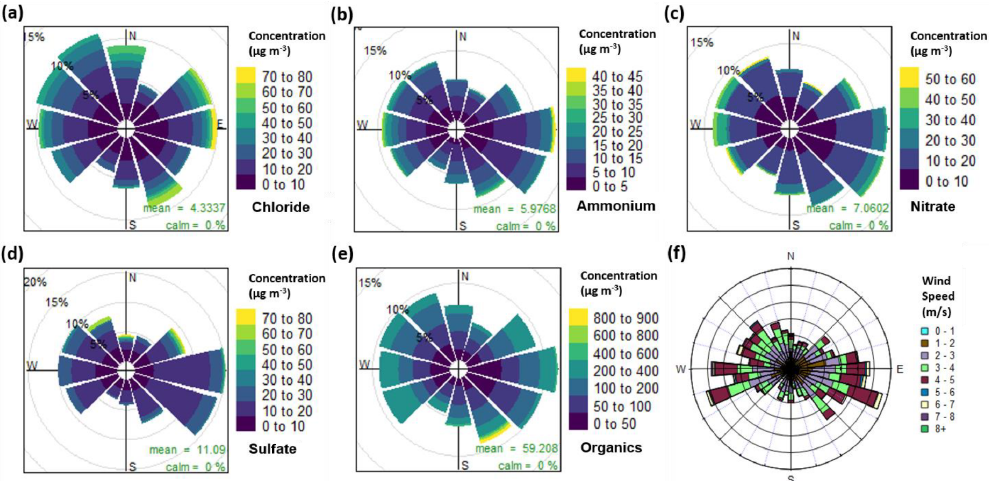
Figure 3. Pollution roses for (a) chloride, (b) ammonium, (c) nitrate, (d) sulfate and (e) organic aerosol, along with (f) a wind rose plot for all measurement periods combined. The pollution roses show 30 ◦ wind vectors, and their size is proportional to the percentage contribution to the mean concentration. The vectors are divided into concentration bins based on the colour scale in the